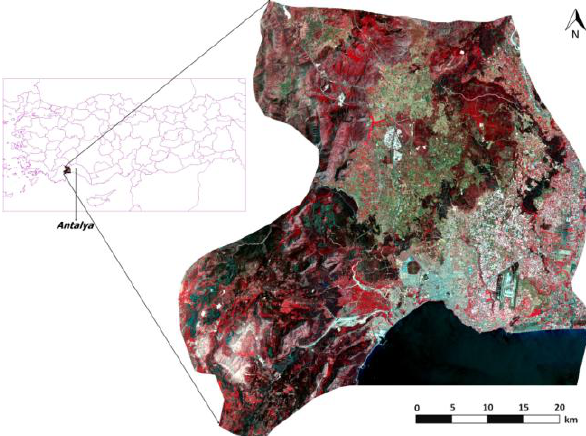
Figure 1. The false color Landsat 8 OLI/TIRS image of the study area and its location in